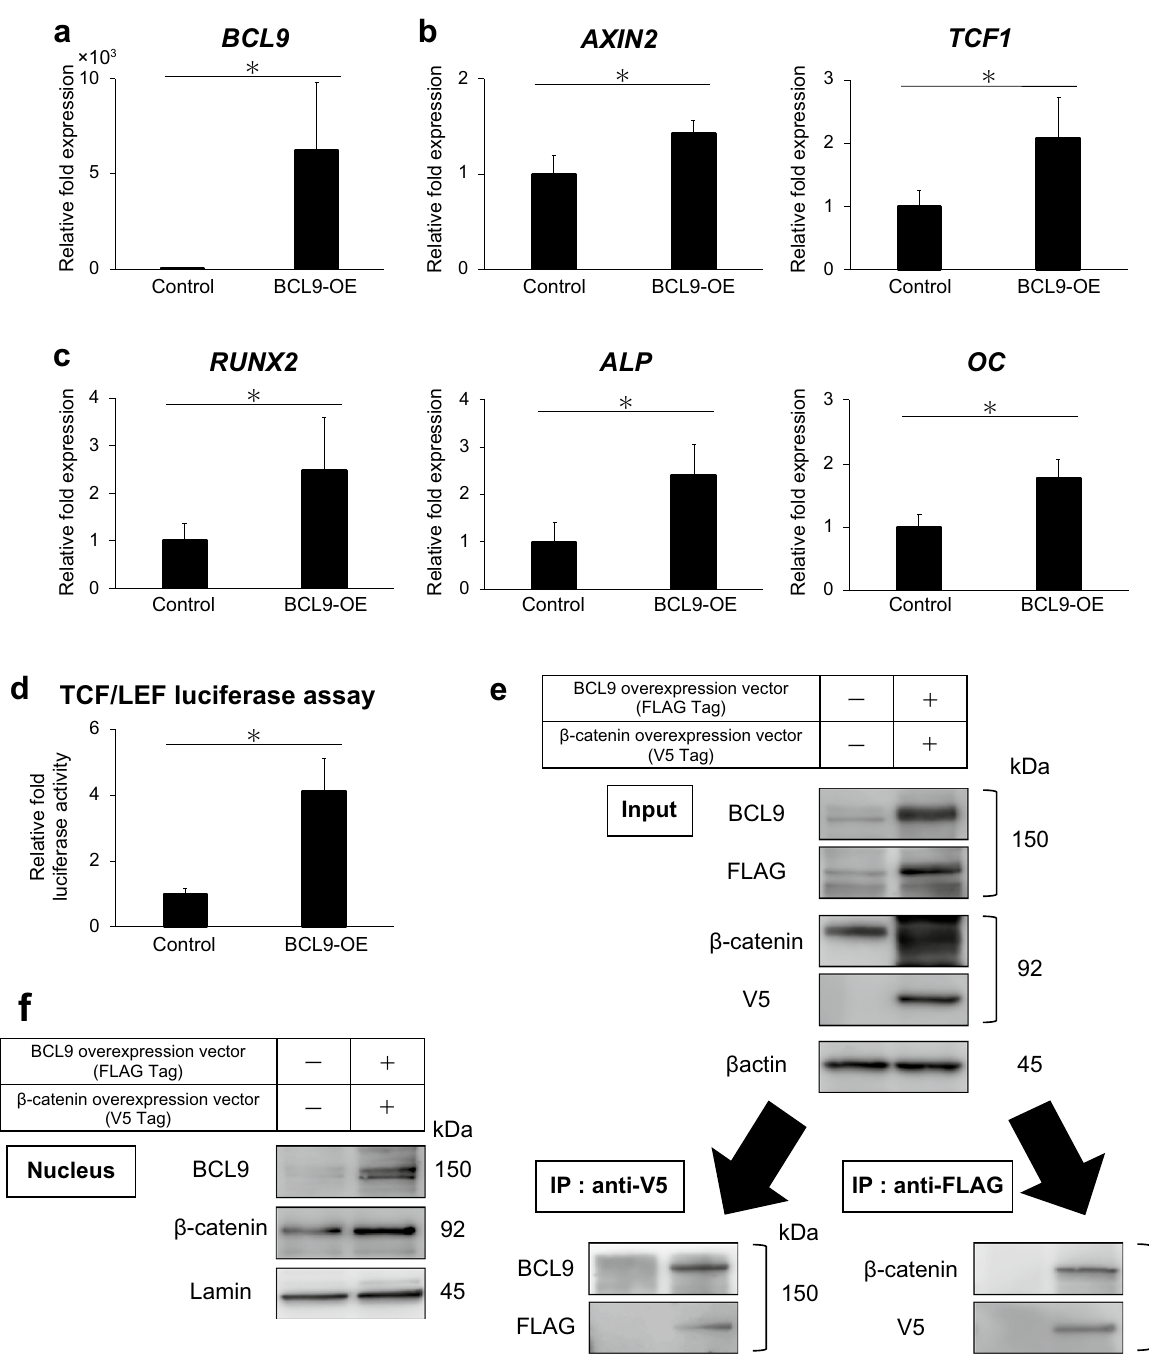
Figure 4. BCL9 overexpression promotes osteo/odontoblast differentiation and Wnt/β-catenin signaling. ( a – c ) BCL9 overexpression upregulates the mRNA expression of BCL9, Wnt/β-catenin target genes (AXIN2 and TCF1), and osteo/odontoblast differentiation markers (RUNX2, ALP, and OC) for 24 h. ( d ) TCF/LEF luciferase assay showing the activation of Wnt/β-catenin signaling in hDPSCs with BCL9 overexpression for 24 h. ( e ) Immunoprecipitation to detect the binding of BCL9 to β-catenin in BCL9 (FLAG Tag) and β-catenin (V5 Tag) overexpression for 24 h. ( f ) BCL9 and β-catenin protein expression are upregulated in the nucleus of hDPSCs in BCL9 and β-catenin overexpression for 24 h. Full-length blots are presented in Supplementary Fig. 2. Error bars indicate standard deviation (n = 4). *p <